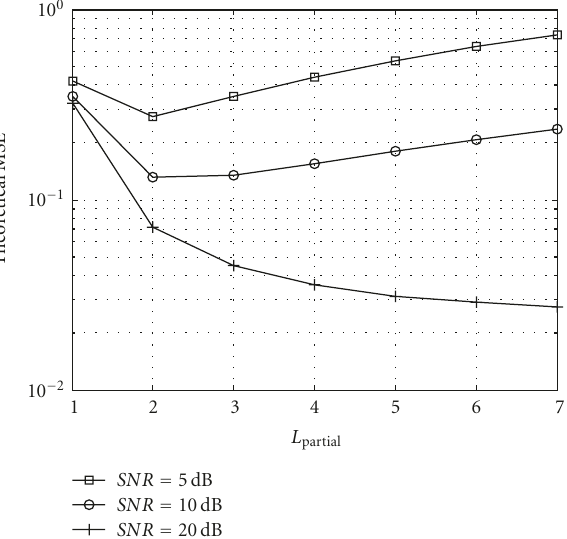
Figure 4: LNR comparison when M = 16.